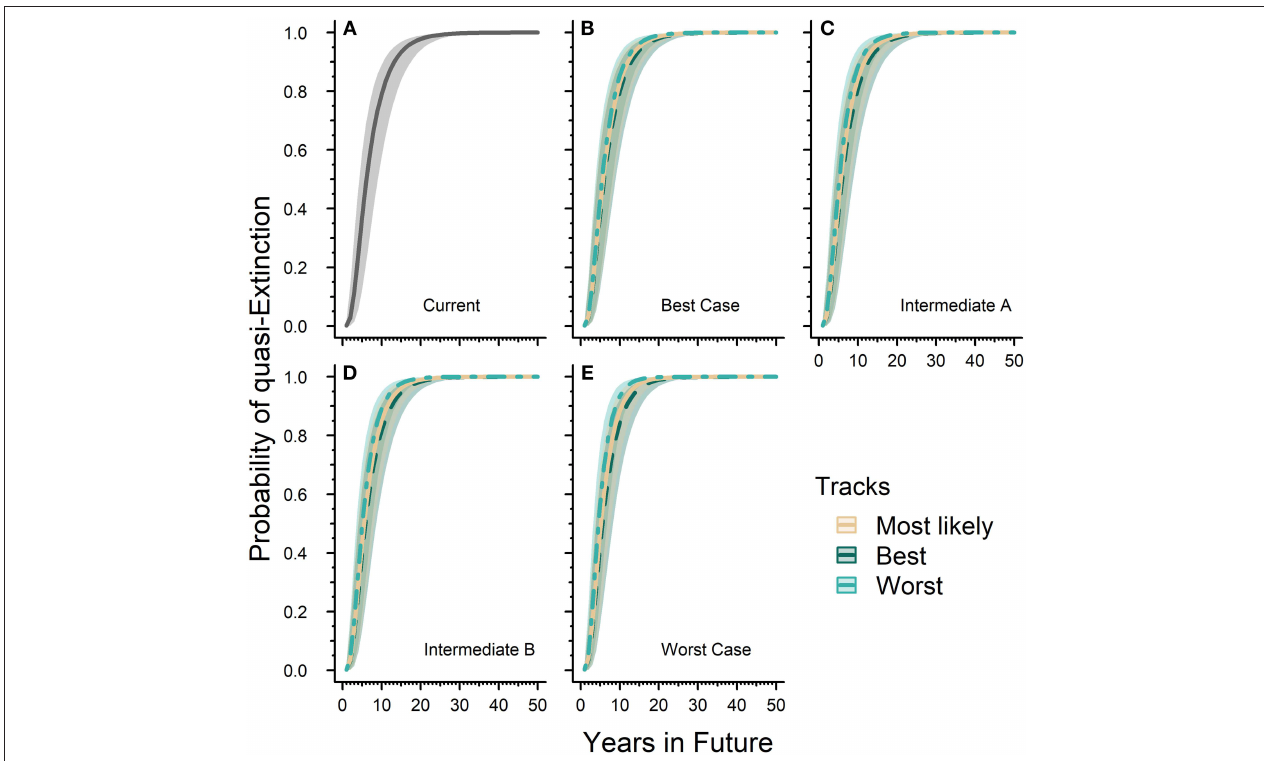
FIGURE 3 | Western monarch population future risk of quasi-extinction. Sub-figure (A) represents the “current” projected probability of quasi-extinction with only the effects of lambda and environmental stochasticity and no threats where the solid line is mean estimate and the gray ribbon is the associated 95% confidence interval. The remaining sub-figures (B–E) represent the projected probability of quasi-extinction under varying future scenarios that include population responses to threats. Sub-figures (B–E) contain three tracks for each scenario, which are represented by different line types and colors (see legend). Lines represent mean estimates and shaded ribbons are 95% confidence intervals. For all sub-figures the 95% confidence intervals cover the full range of quasi-extinction thresholds (20,000–50,000 monarchs).